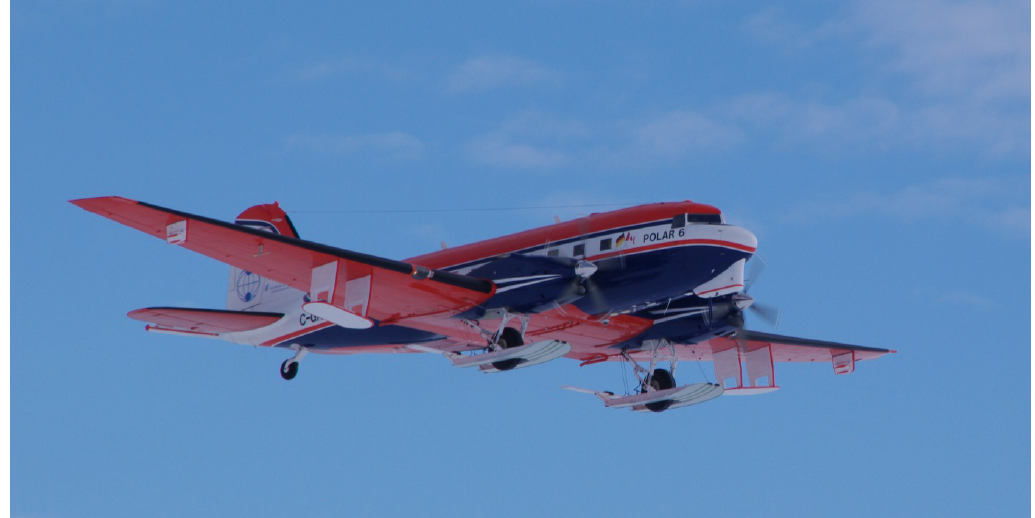
Figure 2: Polar6 with ice thickness radar antennas (large boards) and high frequency accumulation radar antennas (small housings near wing tips) underneath the wings, Photo: Alfred-Wegener-Institut/D. Steinhage.